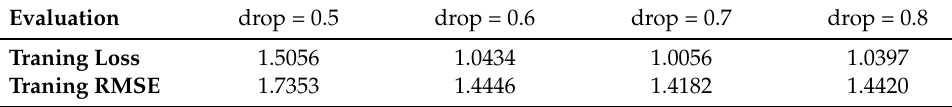
Table 5. Ablation study of different dropout rates.